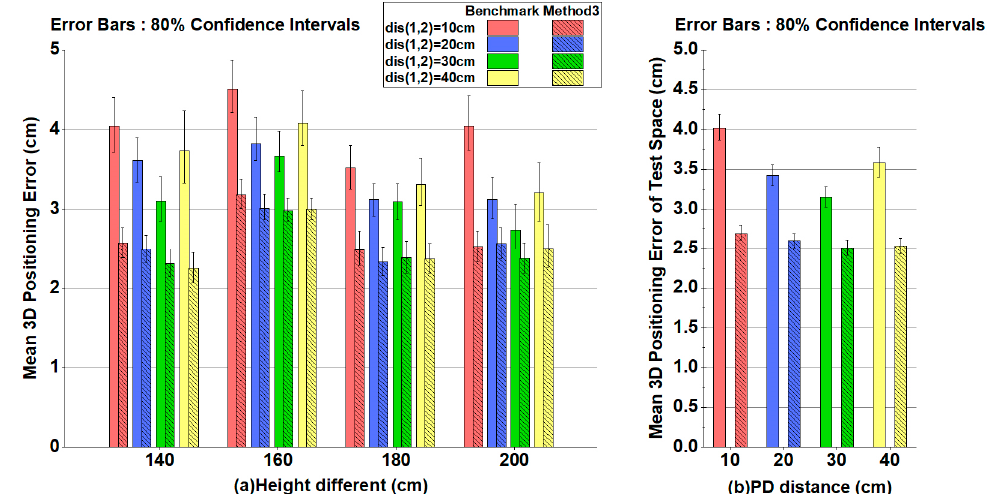
Figure 7. ( a ) Mean 3D positioning error at different heights for dis (1,2) = 10/20/30/40 cm with Benchmark/Method 3. ( b ) Mean 3D positioning error in the test space for dis (1,2) = 10/20/30/40 cm with Benchmark/Method 3.